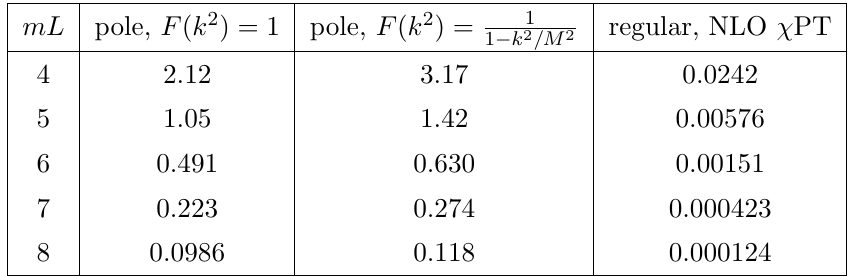
Table 1 . Numerical estimates of the pole and regular contributions to (cid:1) a s ( L ), normalized to a HVP,LO